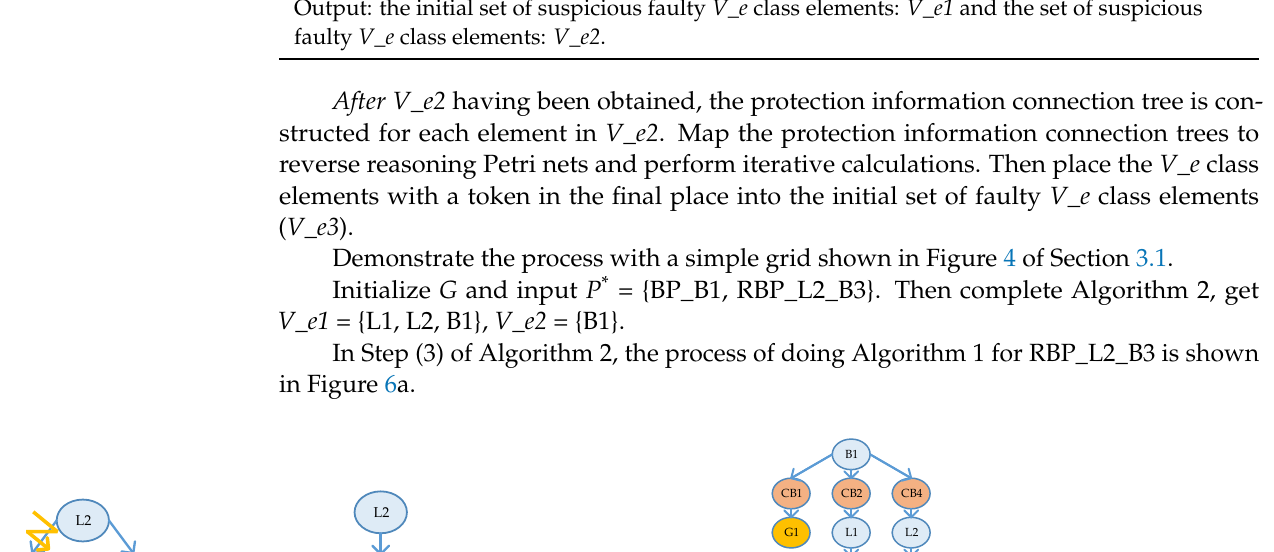
Figure 5. Algorithm 2 flow chart. Algorithm 2 Preliminary search algorithm for suspicious faulty V_e class elements: